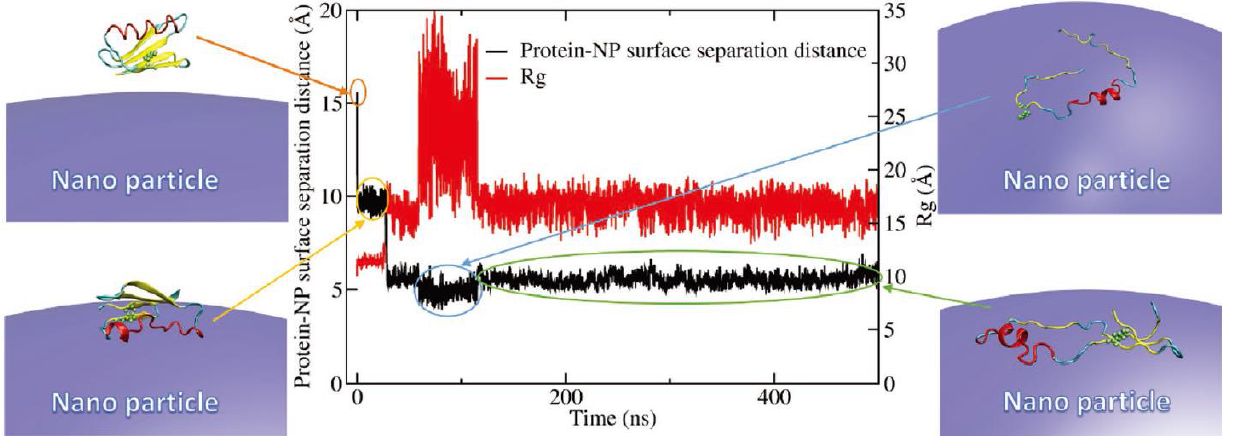
Figure 6. The distance between a protein and a nanoparticle surface, and the radius of gyration of a protein as a function of simulation time. Reproduced with permission from [45], WILEY-VCH, 2017.